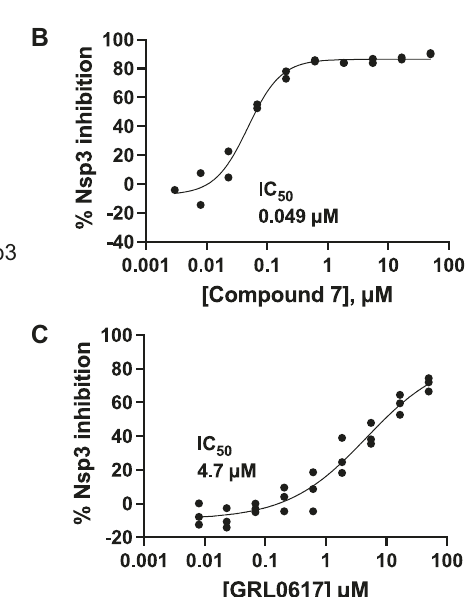
Fig. 6 | Inhibition of the deISGylase activity of full-length SARS-CoV-2 hemag- glutinin (HA)-Nsp3 transiently expressed in HEK293T cells. A Anti-HA beads after immunoprecipitation (IP) and whole cell lysates probed with anti-HA anti- body. The asterisks indicate immunoglobulin G (IgG) heavy chain (HC) and light chain(LC).Anti-HAbeadswereassayedforNsp3deISGylaseactivityusinganISG15-